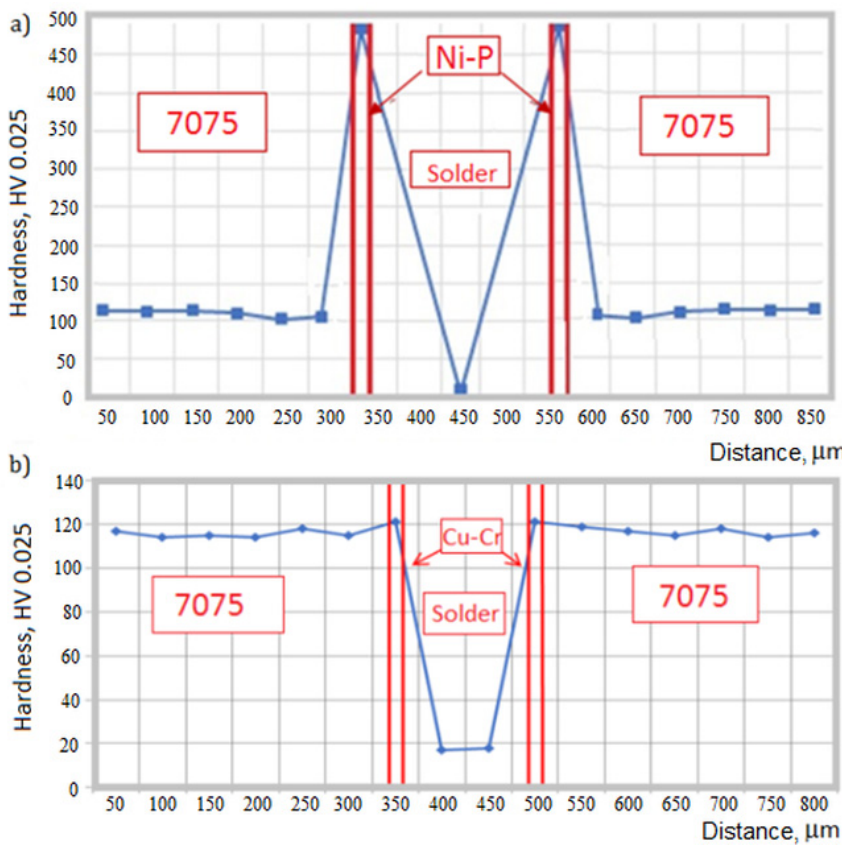
Figure 10. Distribution of hardness HV 0.025 in soldered joints made via Ni-P ( a ) and Cu-Cr ( b ) interlayers.